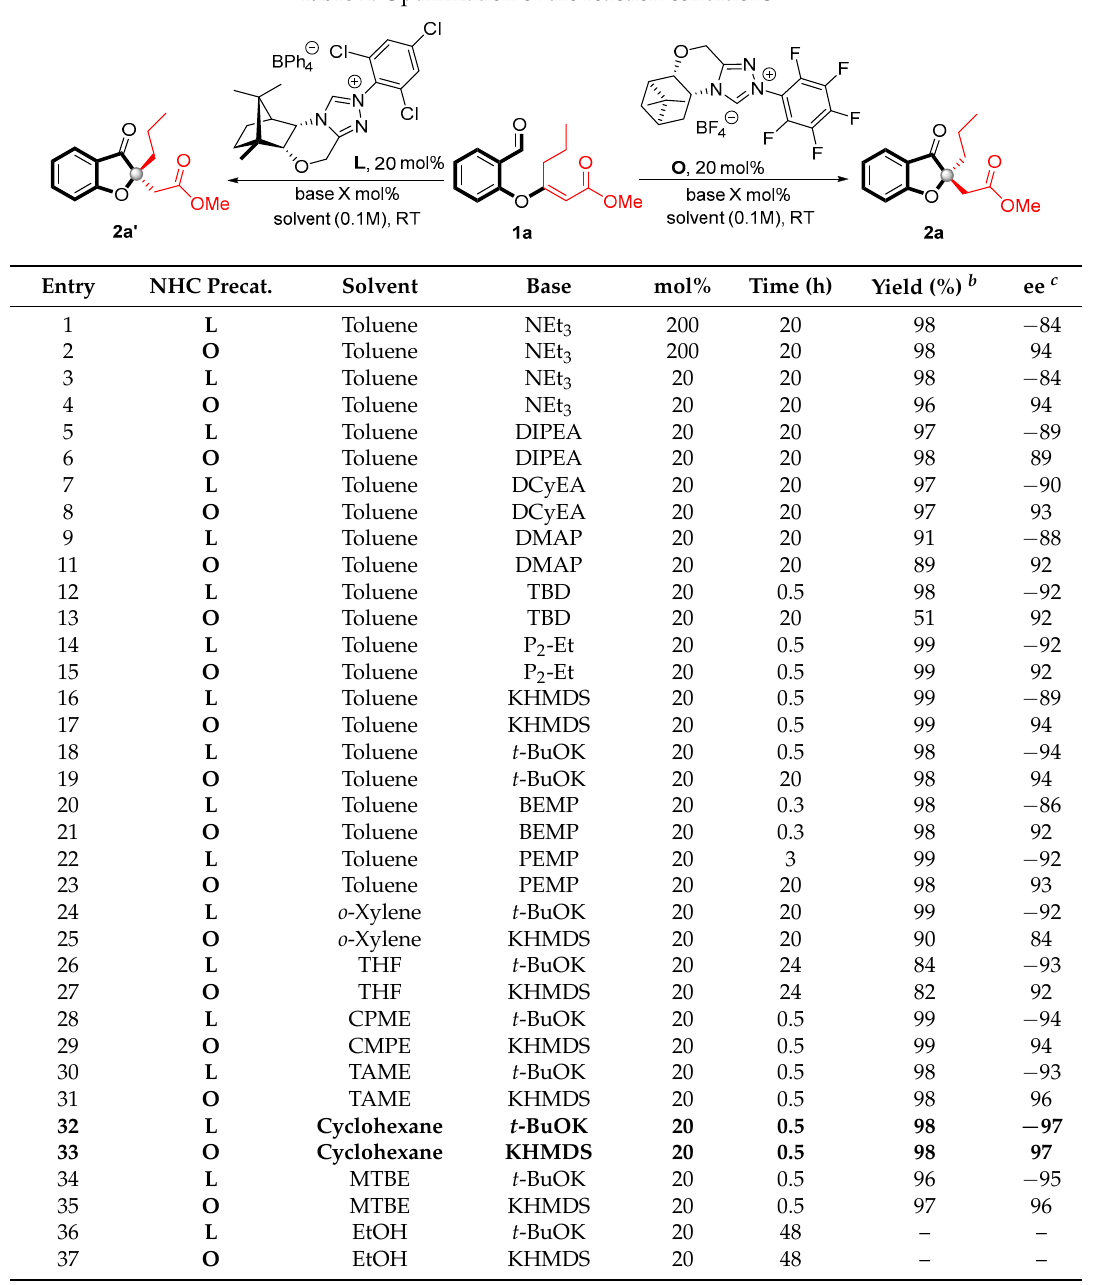
Table 2. Optimization of the reaction conditions a .